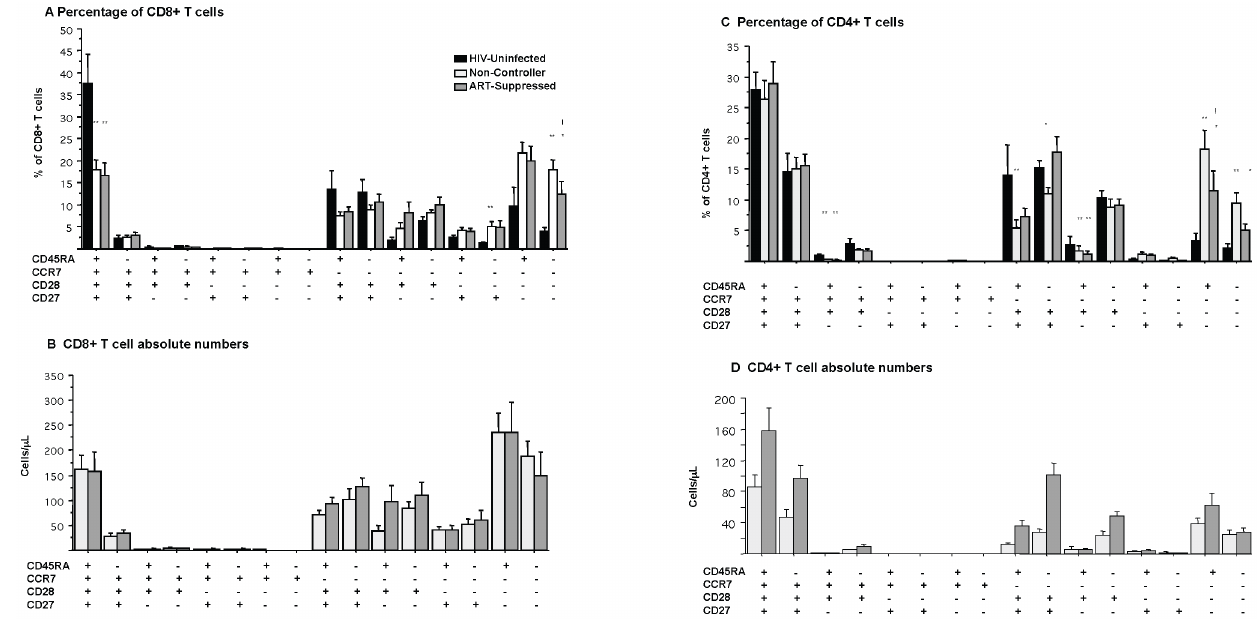
Figure 3. Subpopulations of CD4 + and CD8 + T cells. CD4 + and CD8 + T cell subpopulations were characterized with surface staining for CD27, CD28, CCR7, and CD45RA. Each of the sixteen subpopulations is shown as a percentage of total CD8 + (A) or CD4 + (C) T cell populations. Also shown are the absolute numbers of CD8 + (B) and CD4 + (D) T cell subpopulations. * represents p , 0.05 compared to HIV-uninfected population; ** p , 0.01 compared to HIV-uninfected population; ! Is comparison between non-controllers and